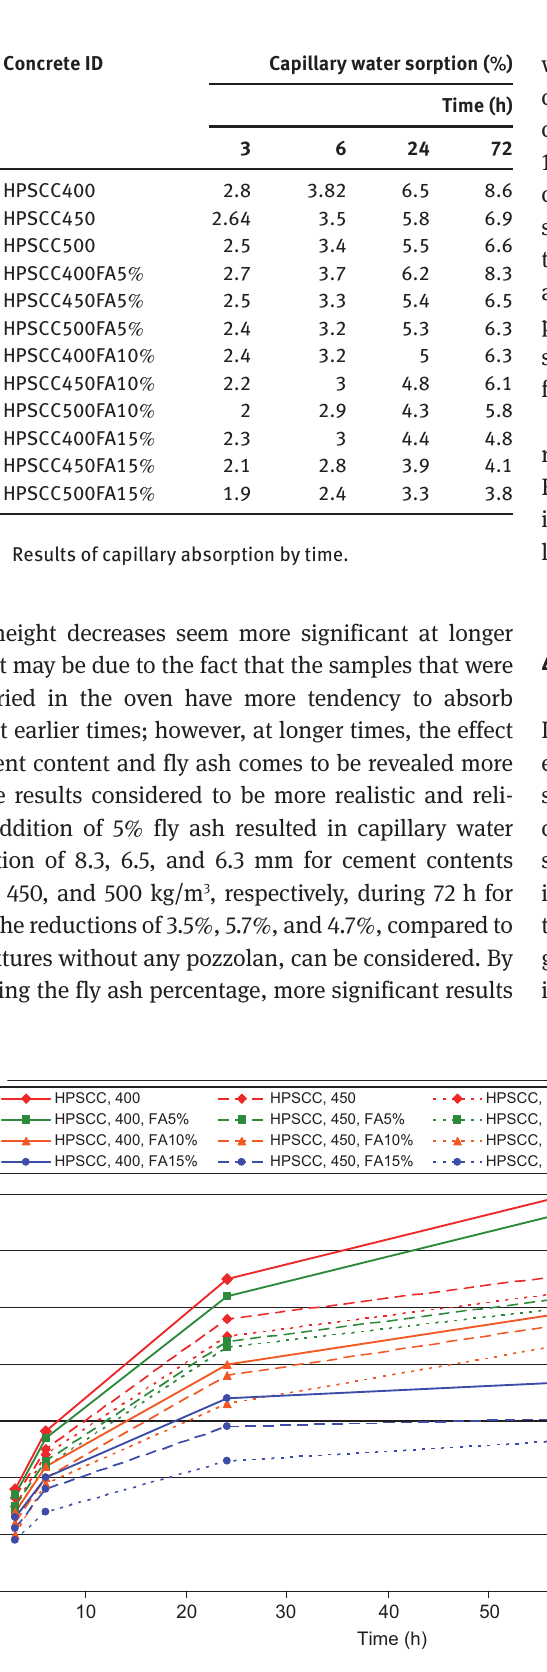
Figure 9 Capillary absorption vs. time for mixtures with different cement contents and fly ash